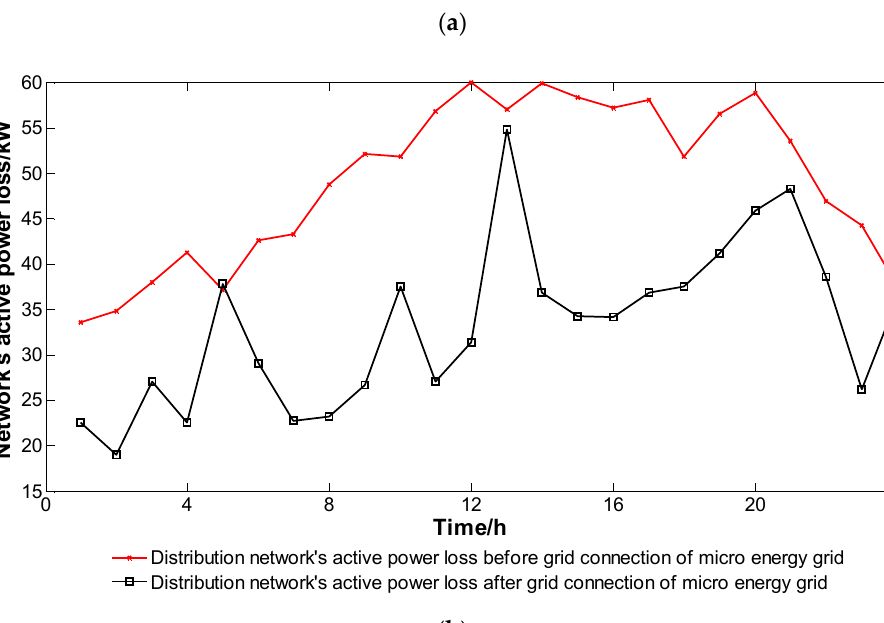
Figure 9. Comparison of the network’s active power loss before and after the grid connection of the micro energy grid on a typical day in the winter ( a ), and in the summer ( b ).